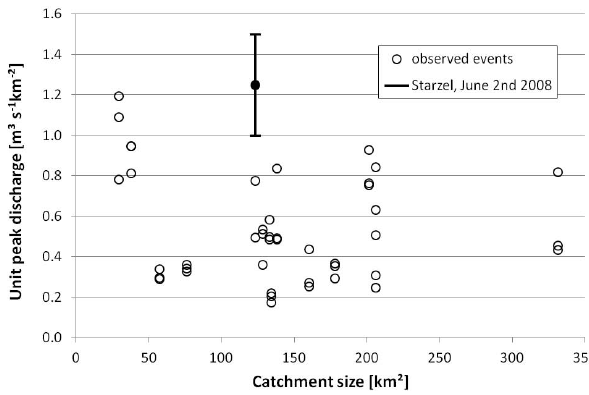
Fig. 3. Unit peak discharges vs. catchment size for the three highest observed flood peaks observed in 15 catchments in the Neckar river system near the Starzel. The uncertainty range corresponding to the Starzel flash flood peak estimated in Rangendingen is also